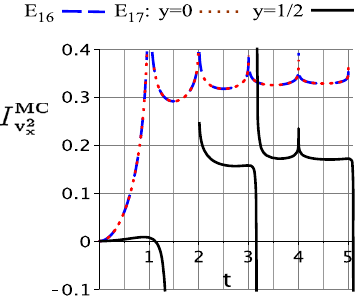
Fig. 1 Time evolution of the x -component of the orientability indica- ( x , t ) in units of q 2 / m 2 for a test particle with mass m and tor I MC v 2 x charge q in Minkowski spacetime with spatial section endowed with the non-orientable and global inhomogeneous E 17 and orientable E 16 topologies, both with compact length a = 1. We show one curve for the globally homogeneous E 16 (dashed line) and two curves for E 17 : dotted and solid lines, for the particle at the positions P 0 = ( x , 0 , z ) and P = ( x , 1 / 2 , z ) , respectively. The figure illustrates the topolog- ical inhomogeneity of E 17 , and shows that when the degree of inho- mogeneity is frozen the indicator curves for E 17 [for the particle at P 0 = ( x , 0 , z ) ] and E 16 [for the particle at generic P = ( x , y , z ) ] coincide